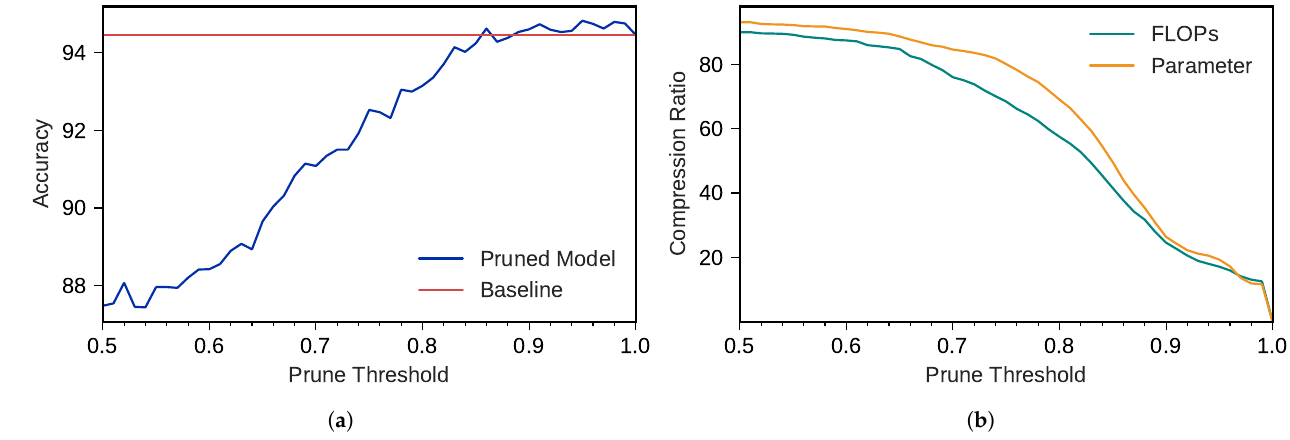
Figure 2. Results of pruning experiments on CIFAR10 with pruning thresholds from 0.5 to 1.0. ResNet-56 model was pruned in the experiment. ( a ) Accuracy. ( b ) Compression ratio of FLOPs and parameters.